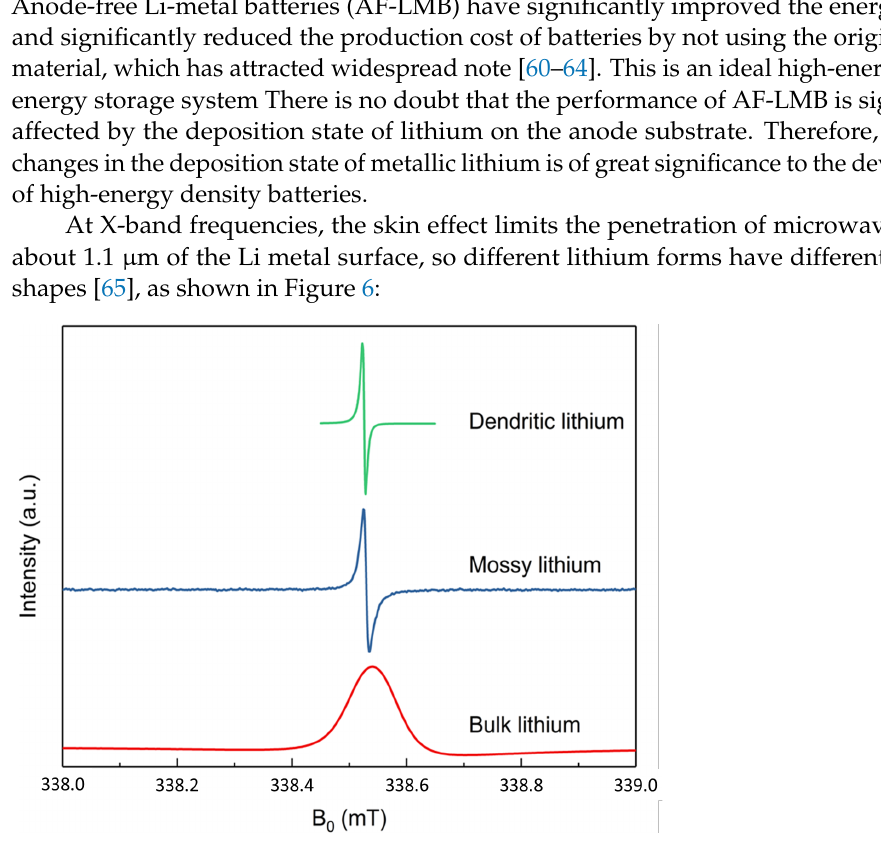
Figure 6. First derivative CEPR signal, as measured in a field-swept EPR experiment examining metallic lithium with different morphologies. The peak-to-peak line-width is minimal for dendritic lithium with ca. 0.005 mT (green), showing a Lorentzian line-shape. For mossy lithium, it increases to 0.03 mT (blue). It reaches a maximum for bulk lithium with ca. 0.15 mT (red), showing a Dysonian line-shape. Reproduced with permission from ref. [65] . Copyright 2018, copyright Springer Nature.